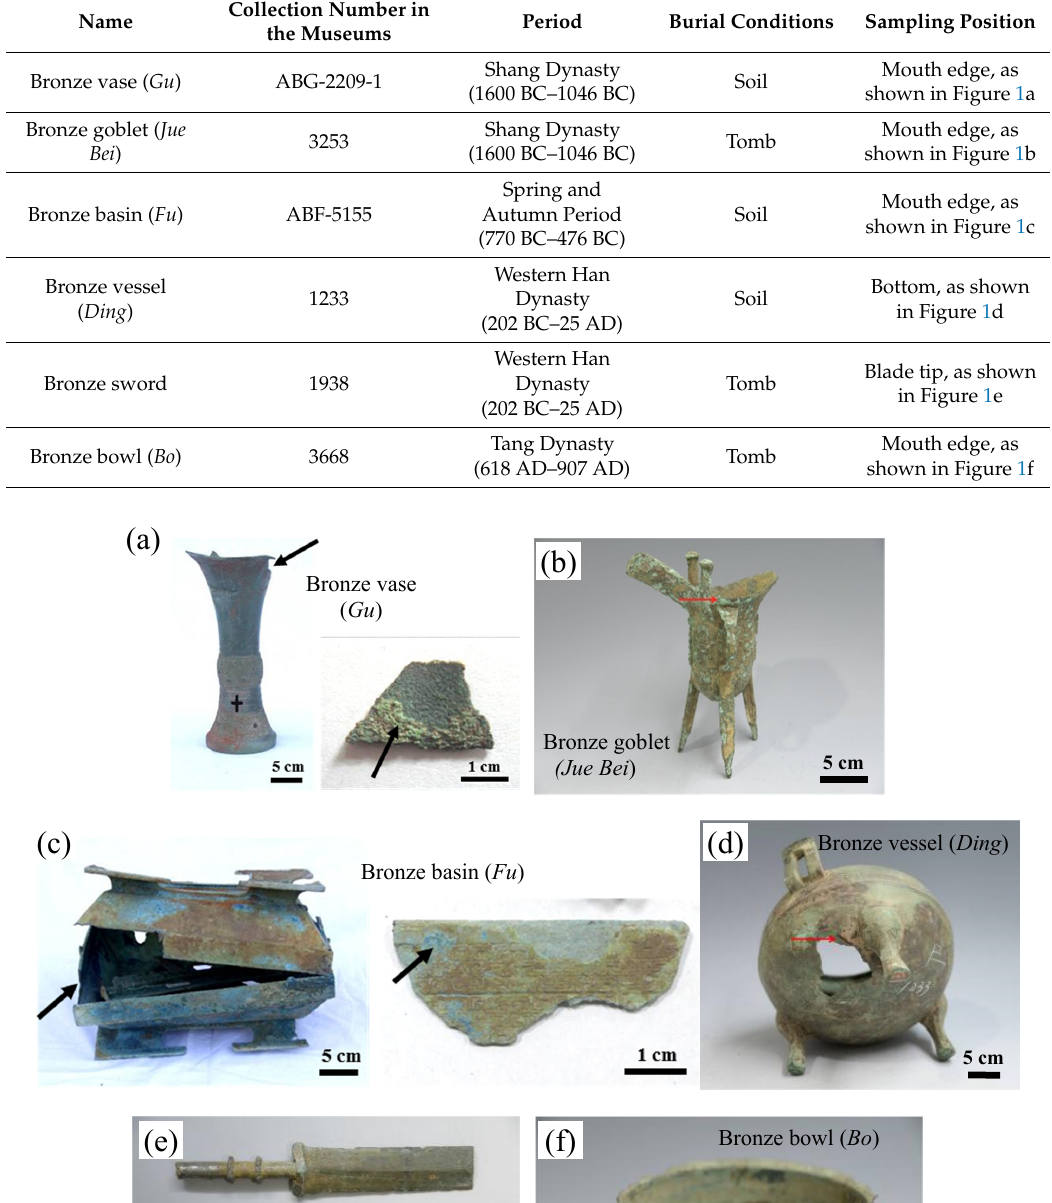
Table 1. Information of the ancient bronzes.